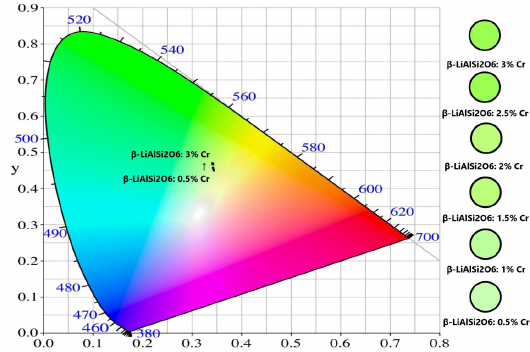
O :3%Cr sample. The micrograph has a magnification of 1000x. 2 6